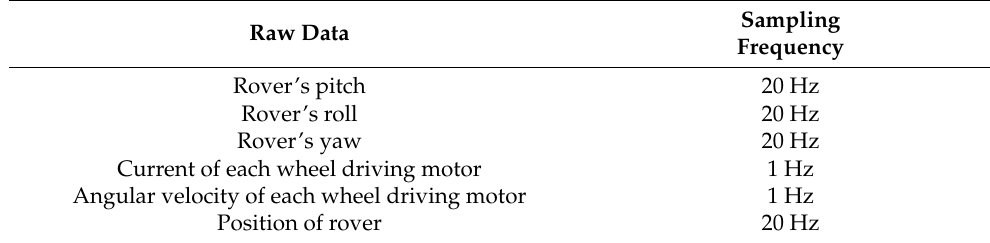
Table 2. The data collected in ground